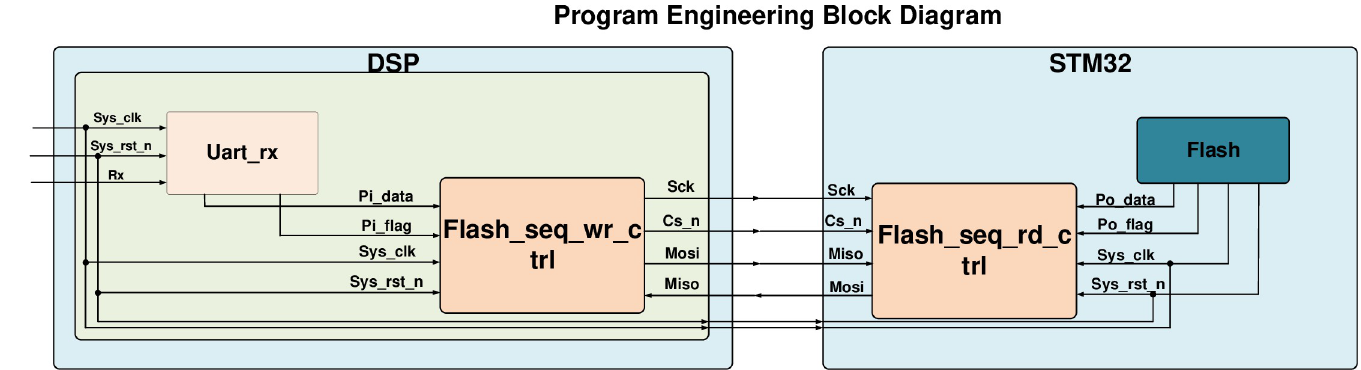
Fig 20. Program engineering block